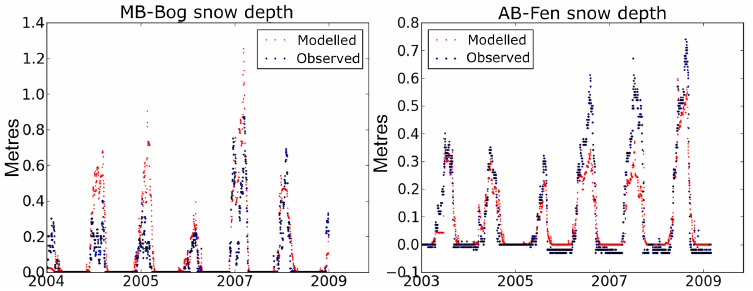
Figure 5. Simulated and observed daily average snow depth (m) in the MB-Bog and the